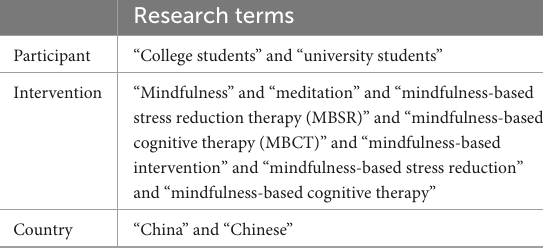
TABLE 1 Final search